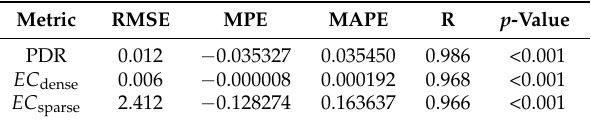
Table 4. Prediction performance statistics.